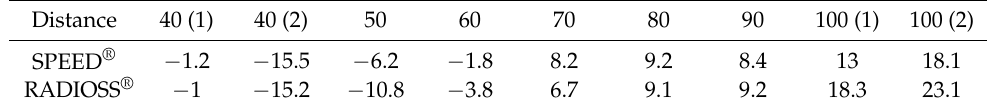
Figure 16. Configuration of the underwater explosion simulation of a detonating cord. The explosive is set in the centre of the mesh domain with numerical gauges from 40 to 100 radii away from it with a 5 radii step. The element size is equal to 0.05 mm with SPEED ® and 0.25 mm with RADIOSS ® , and the domain is a 210 radii square. Table 5. Relative difference (%) between the peak of overpressure from simulation with SPEED ® and RADIOSS ® simulation with incident pressure calculated with method presented in Section 2.3 and measurement (Figure 7). Since 2 shots were performed at 40 and 100 radii, both are presented with a specific label namely “(1)” and “(2)”. The percentage is computed with respect to measured values. Distance 40 (1) 40